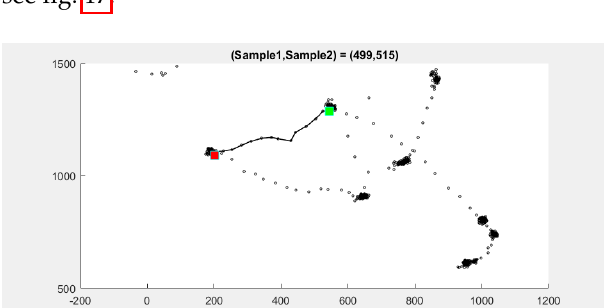
Figure 16 . Scatter plot for dataset 2.3 between sample 502 (green square) and sample 507 (red square). ITop detects the gap at the same location at samples 499–515 and is therefore approximately twice as long, see fig. 17.